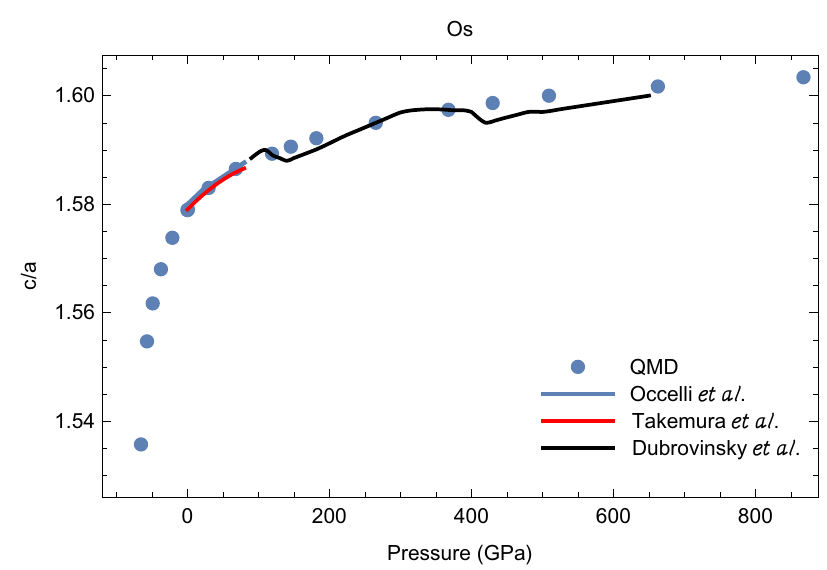
Figure 3. The c / a ratio as a function of P : QMD vs. the available experimental data from different Figure 3. The c/a ratio as a function of P: QMD vs. the available experimental data from different literature sources literature sources [17,31,32].